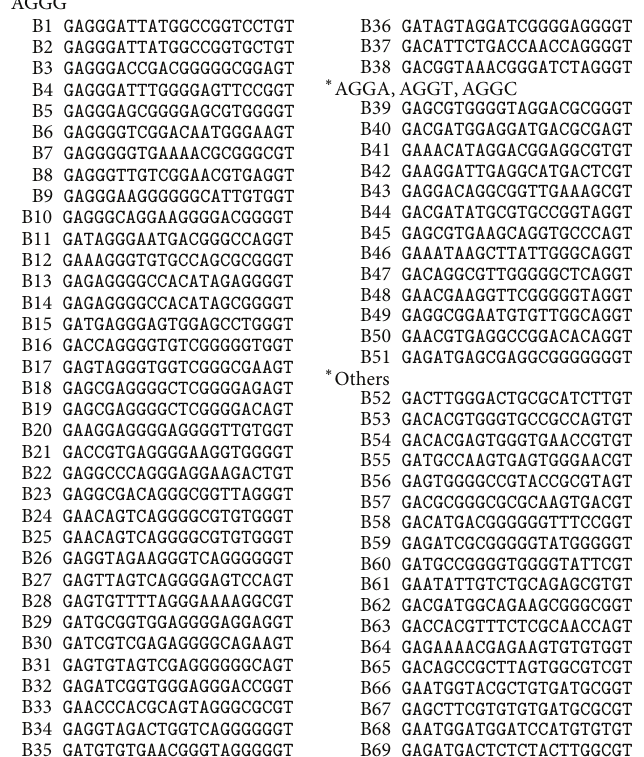
Figure 3: Alignment of 69 selected oligonucleotides bound to ZNF191(243-368). There are 51 sequences (74%) containing AGGG motif or similar AGGA, AGGT, AGGC motif, and the content of GC in others is